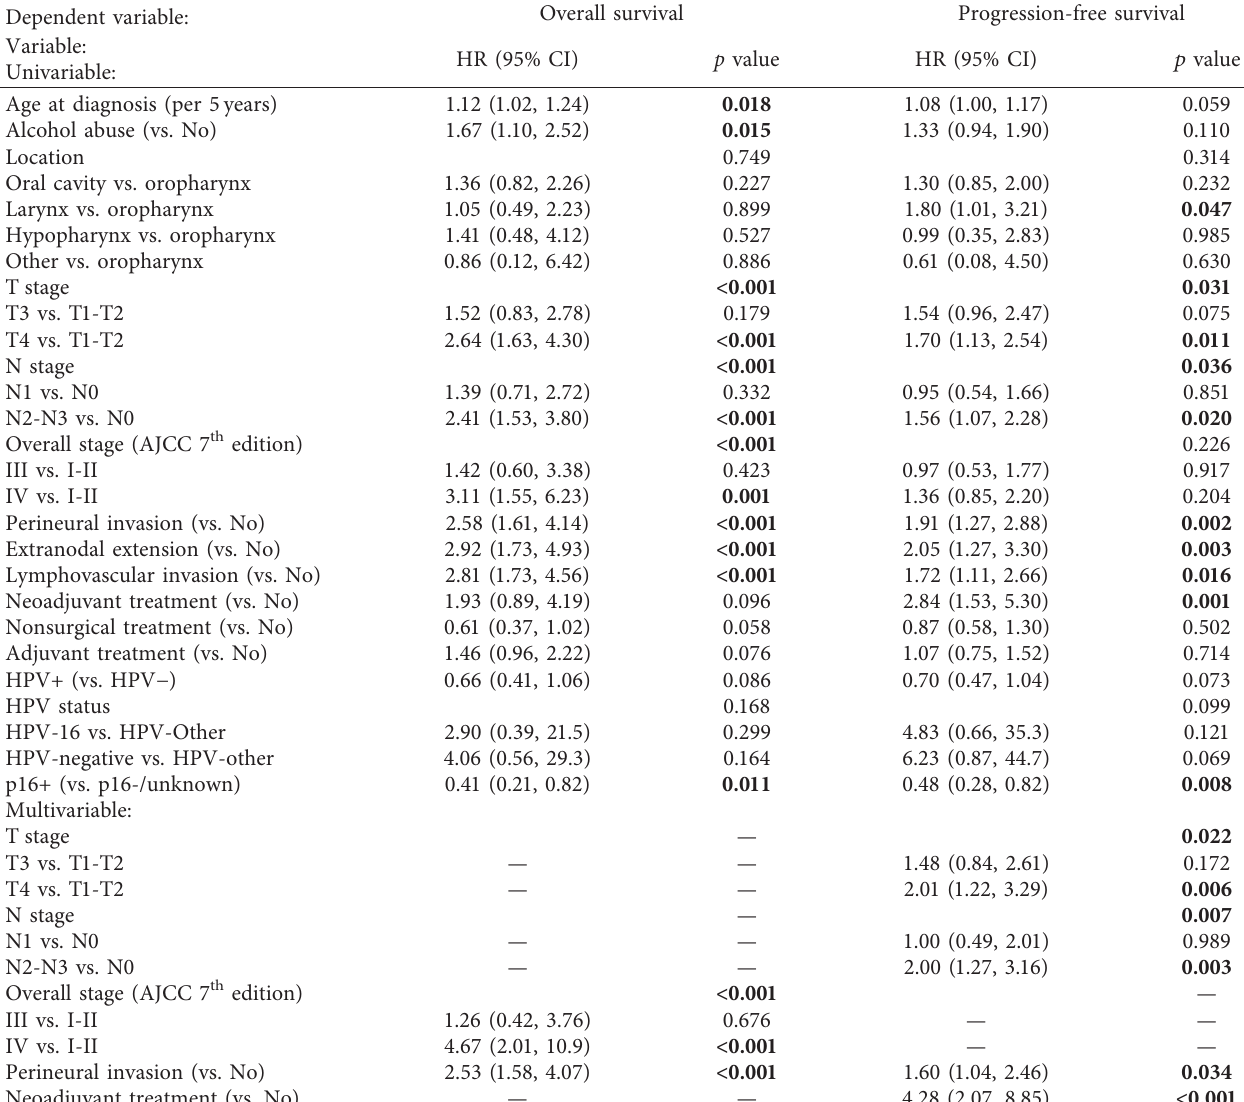
Table 2: Univariable and multivariable Cox proportional hazards regression for overall survival and progression-free survival ( n � 280). Dependent variable: